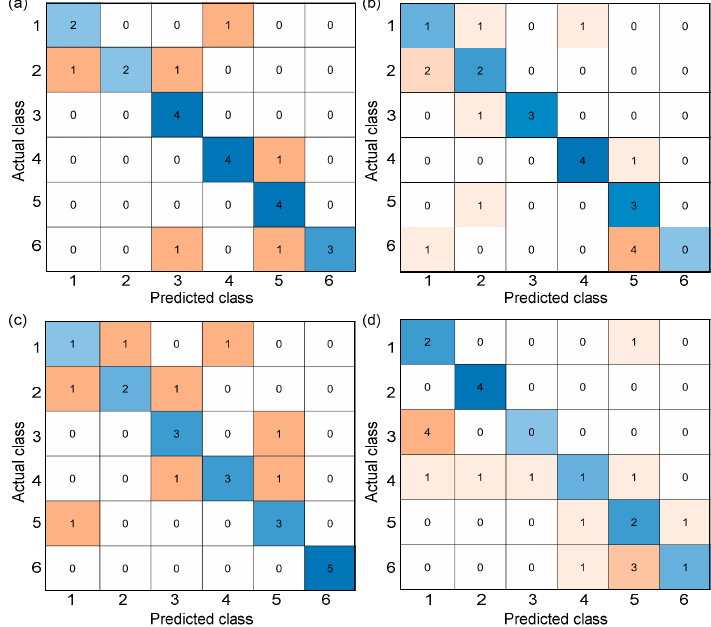
Figure 14. Confusion matrix of different algorithms used in machine learning for classification of thermal damage: ( a ) support vector machine, ( b ) k-nearest neighbor, ( c ) Gaussian Naïve Bayes, and ( d ) decision tree. Table 4. Accuracy and F 1-score of different ML algorithms in classifying the UPV signals using sampling rate equal to 125 kHz and time window equal to 5 ms.